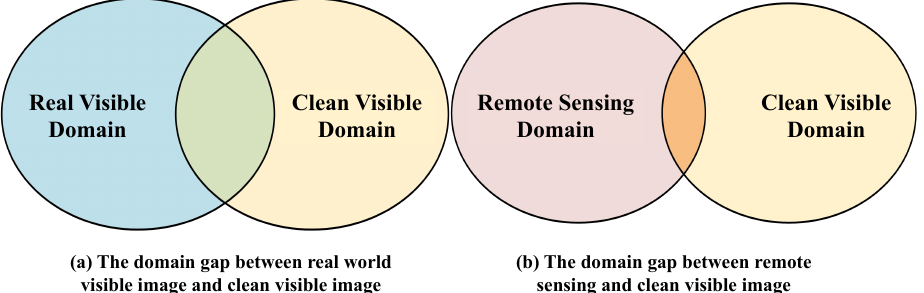
Figure 4. Different domain gaps of the real-world visible domain/visible clean domain and the remote sensing domain/visible clean domain.